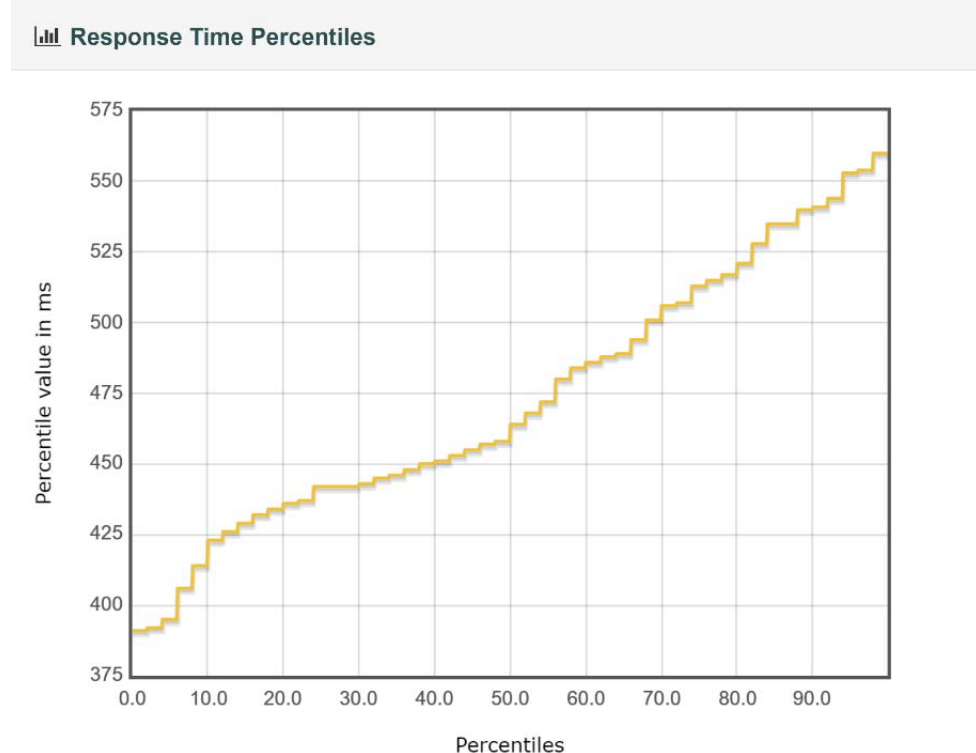
Figure 10. Response time percentiles for 50 edge nodes and the IBM Cloud.